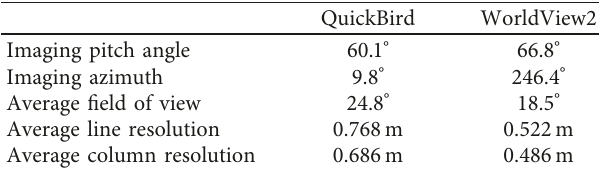
Table 4: LiDAR point cloud data imaging